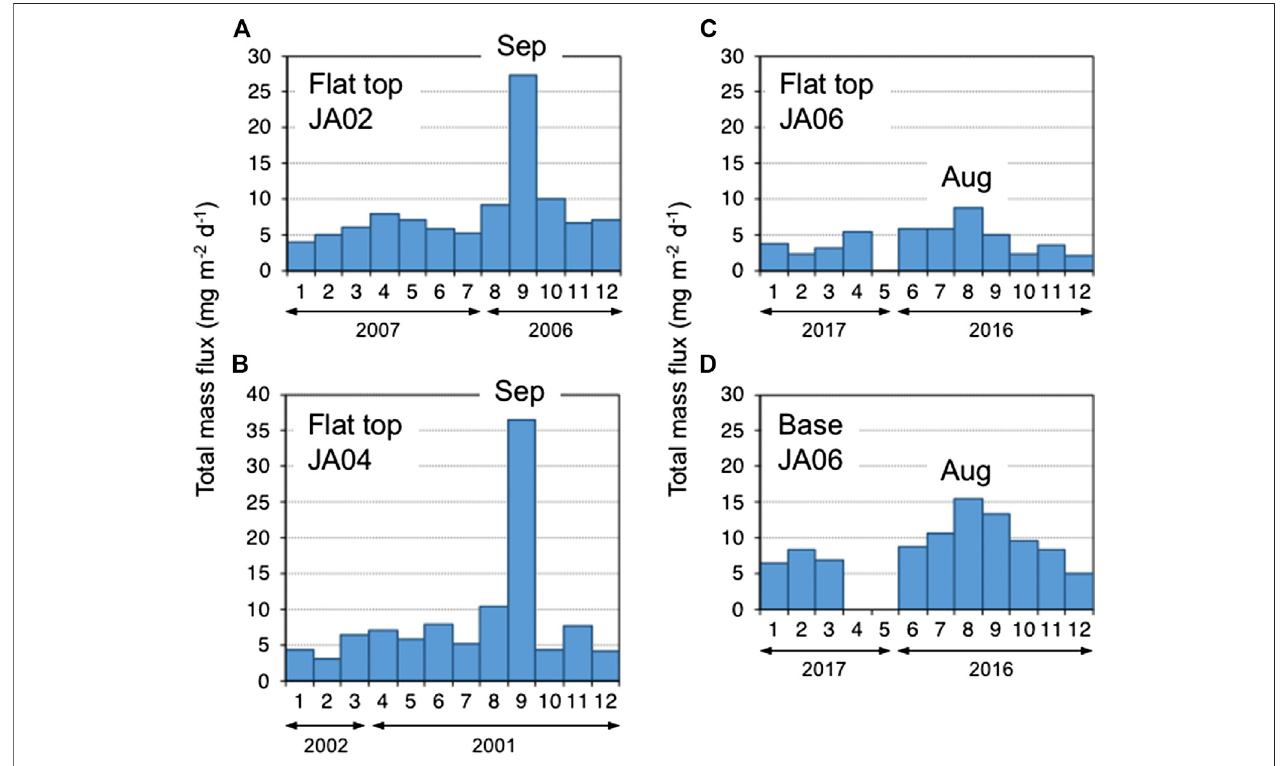
FIGURE 4 | Seasonal variations in total mass fl uxes at shallow sediment traps on the (A) JA02, (B) JA04, and (C,D) JA06 seamounts in Japan ’ s exploration area. Three-letter month designations show the month of peak fl ux for each sediment trap.